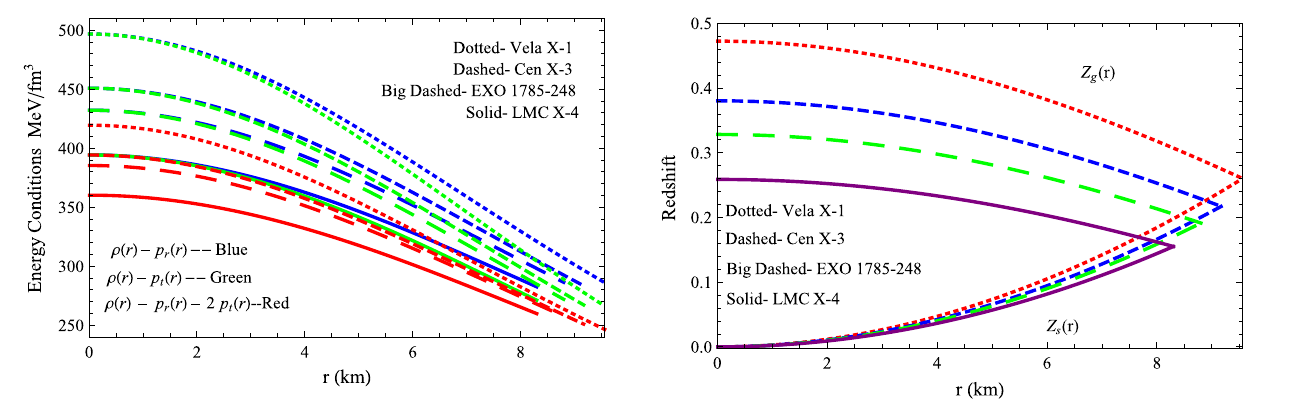
Fig. 7 Surface redshift (above) and gravitational redshift (below) vs the radial coordinate r corresponding to numerical values of constants given in Table 2 for four well-known compact